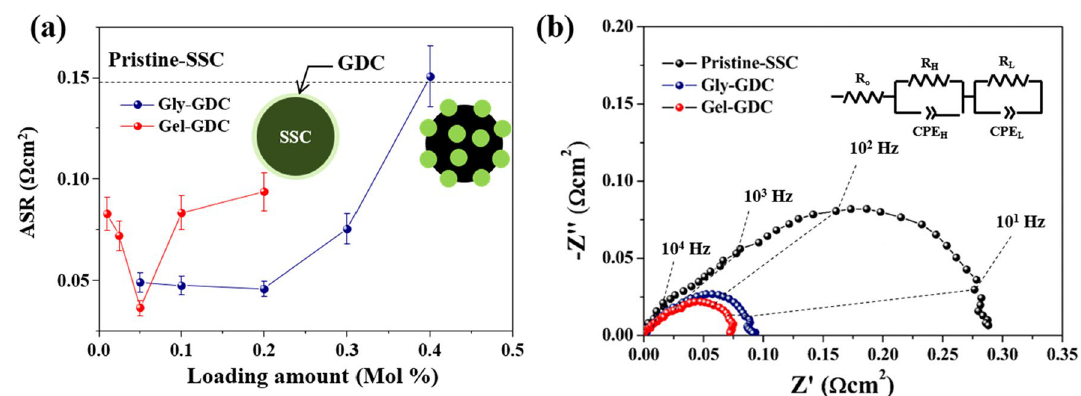
Figure 4. EIS results of Gly–GDC and Gel–GDC. ( a ) Rp of Gly–GDC and Gel–GDC as a function of the loading amount of GDC into the SSC cathode at 650 °C. ( b ) Representative impedance spectra of samples at optimized loading amount at 650 °C; Gly–GDC: 0.2 M, and Gel–GDC: 0.05